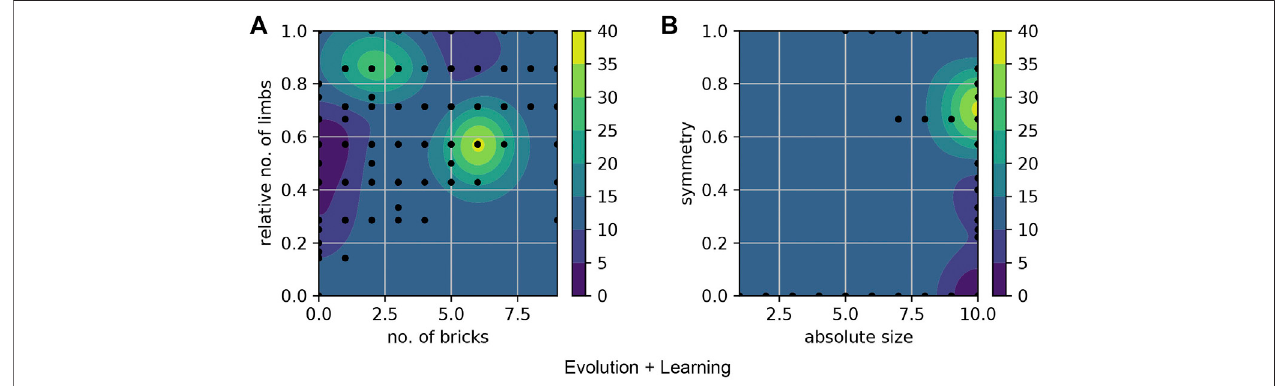
FIGURE 12 | Fitness landscape of Evolution + Learning. (A) the robots with higher fi tness are in the regions where the contour color is brighter (yellow). (B) shows the fi tness landscape of absolute size over symmetry. The highest fi tness robots are highly symmetrical.